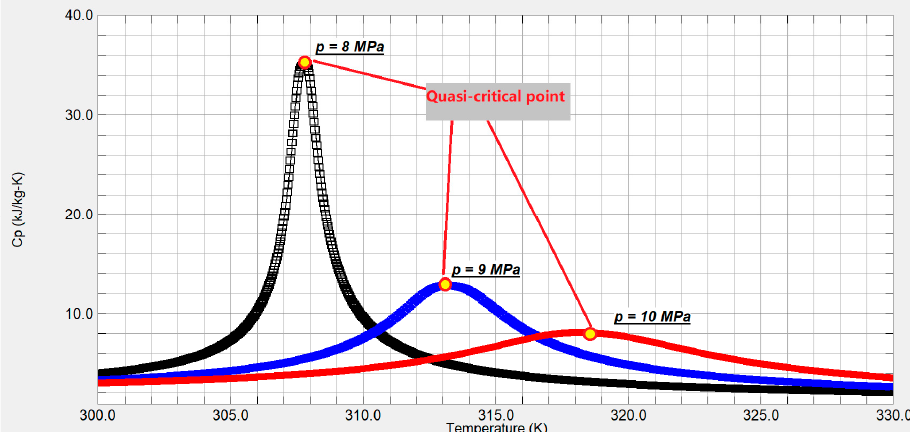
Figure 24. The quasi-critical point of SCO 2 .